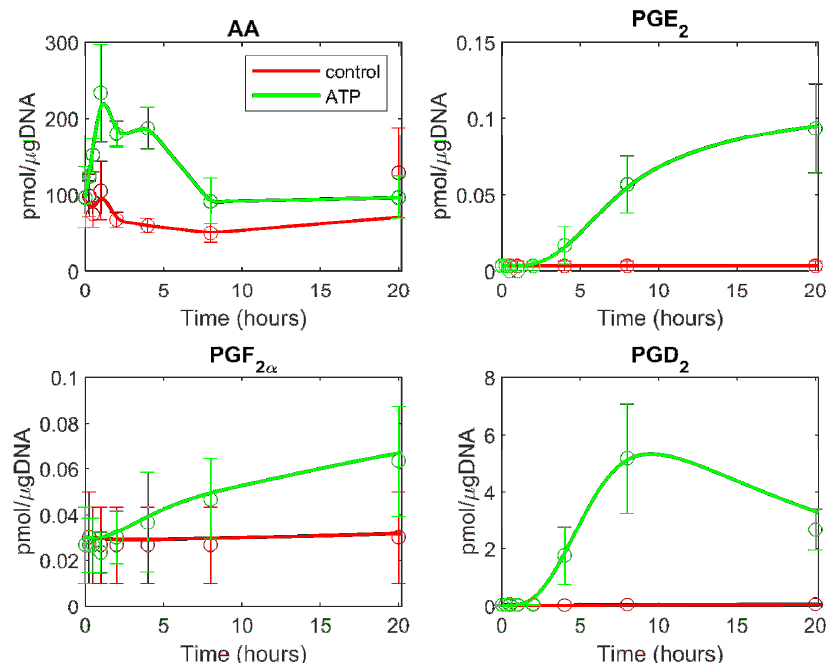
Figure 2. The computational simulation of the eicosanoid profile is generated using the cybernetic model in ATP stimulated BMDM. The mean experimental data (circles) with associated standard error of the mean (SEM) from three replicate experiments ( n = 3) for the ATP stimulated (green) and control (red) cases are taken from the mass spectrometry measurements of lipids. The simulation results are shown for the treatment and control cases (solid green and red curves, respectively). Table 1. Goodness of fit, F -test, for simulated/optimized (adenosine triphosphate (ATP) stimulated data) and predicted (Kdo2-Lipid A (KLA) primed and ATP stimulated) cases. F values smaller than F 0.05 (16, 32) = 0.4580 indicate that the fit-error is statistically smaller than the experimental error; whereas the F values smaller than F 0.95 (16, 32) = 1.97 indicate that the fit-error is statistically comparable to the experimental